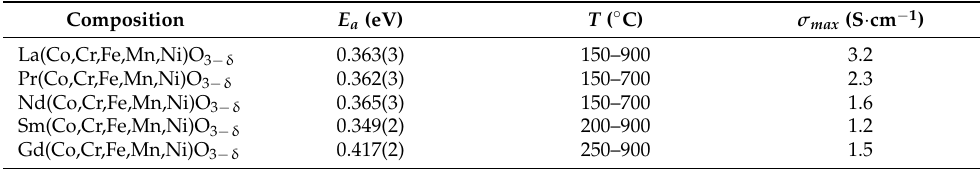
Table 4. The summary of the electrical conductivity properties of the Ln(Co,Cr,Fe,Mn,Ni)O 3 − δ series, including the maximum measured value of conductivity σ max . The results for exemplary, conventional LnTMO 3 perovskites are provided for